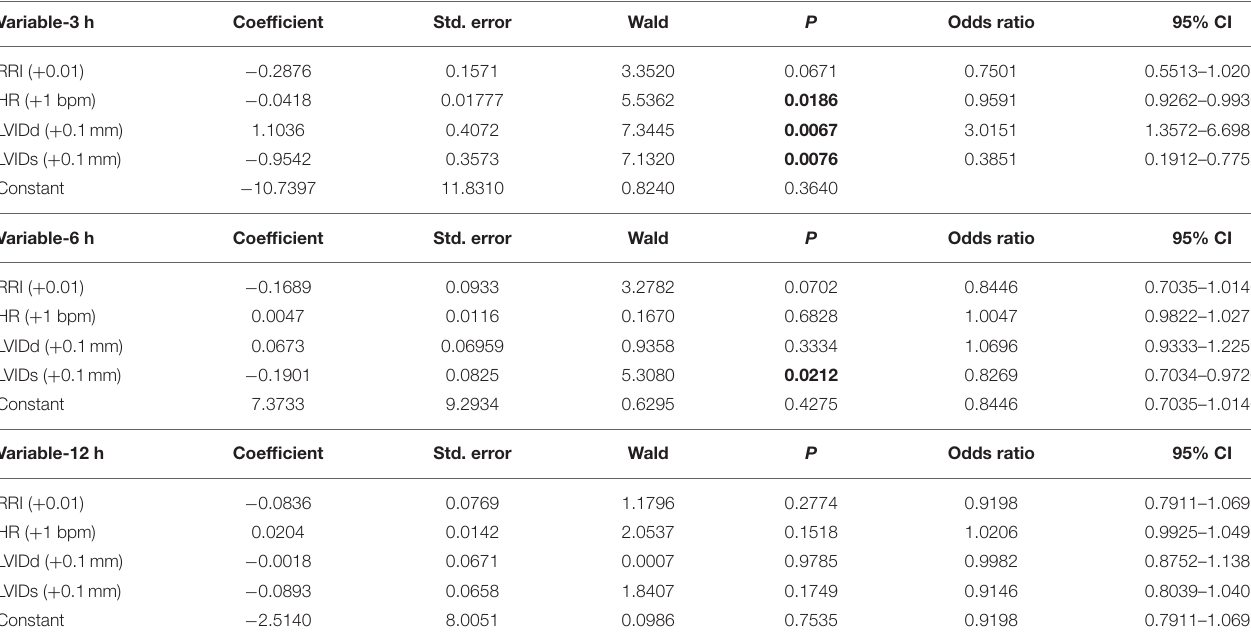
TABLE 2 | Binary logistic regression model for predicting